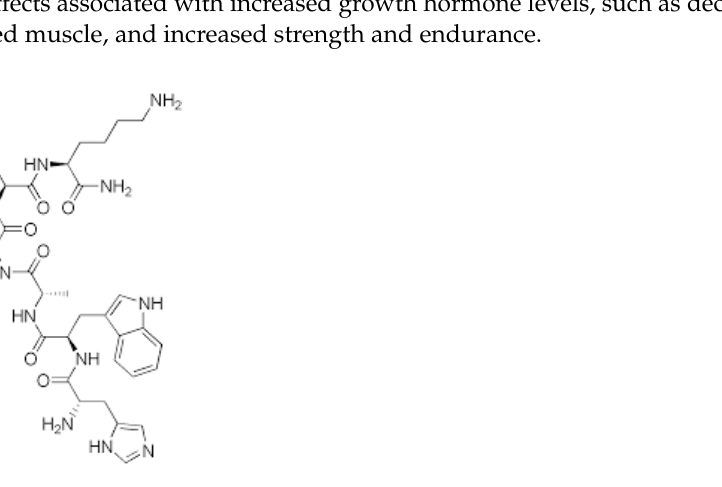
Figure 17. Chemical structure of GHRP-6. Formula: C 46 H 56 N 12 O 6.